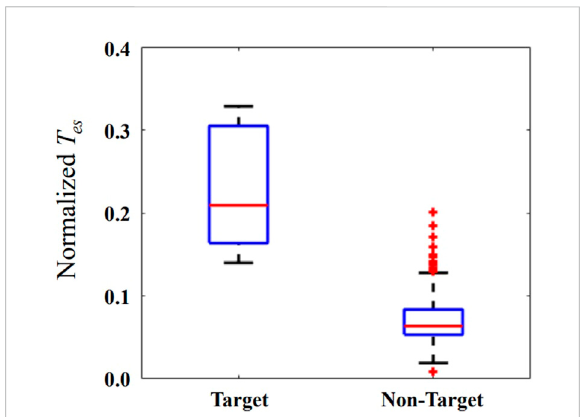
FIGURE 5 The normalized T es when external modulation is applied on the localized target and non-target nodes. The horizontal red bar represents the median, and the blue box represents the rang from fi rst to third quartile, respectively. The horizontal black lines represent the upper and lower limits, and the red plus sign represents outlier